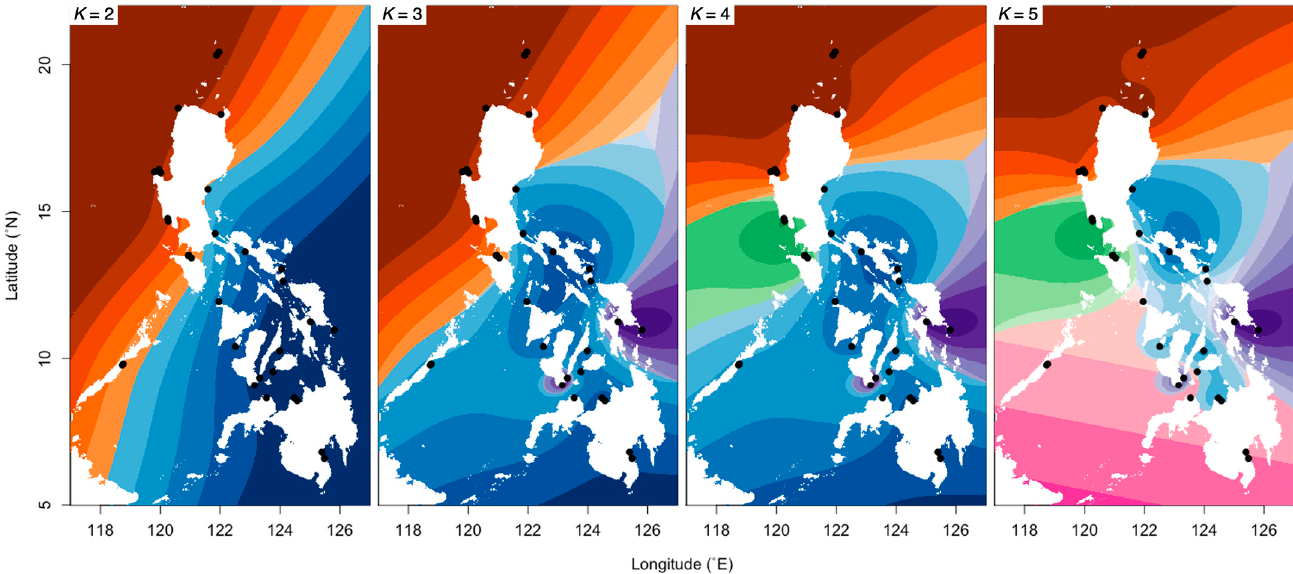
Figure 3. Map showing the frequency of Q-matrices from Bayesian clustering analysis implemented in STRUCTURE using clustering without prior information under the admixture model and assuming correlated allele frequencies. K values of these panels are K = 2 to K = 5.